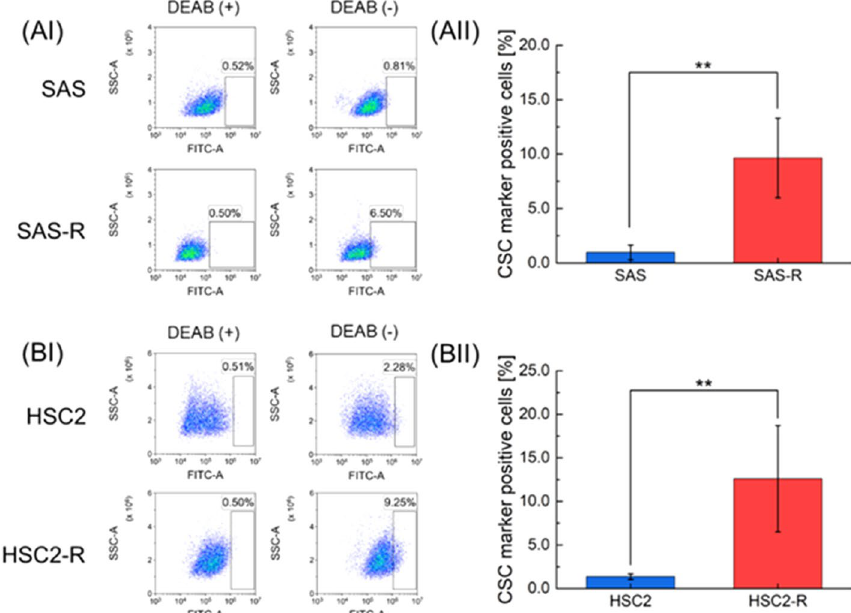
Figure 3. The ALDH (+) population in four cell lines. The fraction of cells expressing ALDH activity was determined by flowcytometric analysis. The cells that tested positive for ALDH activity are shown in the scatter plot on the right. Representative cytogram of (AI) SAS and SAS-R cells, (BI) HSC2 cells and HSC2-R cells. DEAB (+) represents the negative control. (AII) and (BII) show the percentages of ALDH (+) cells subtracted from that of DEAB (+). Bracketed asterisks represent significant differences of P < 0.01 between the two groups.